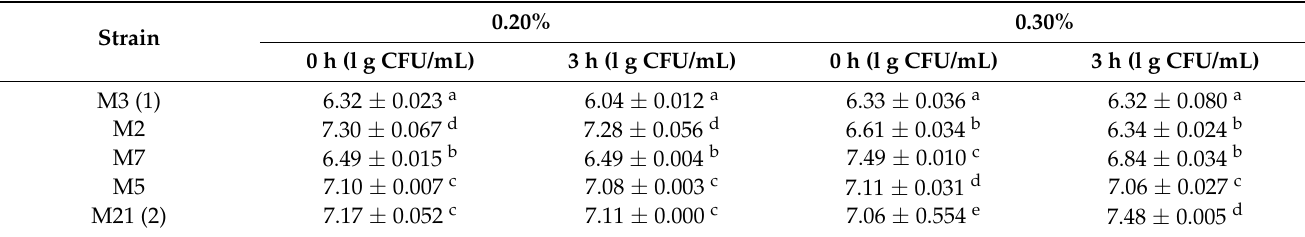
Table 6. Bile salt tolerance of